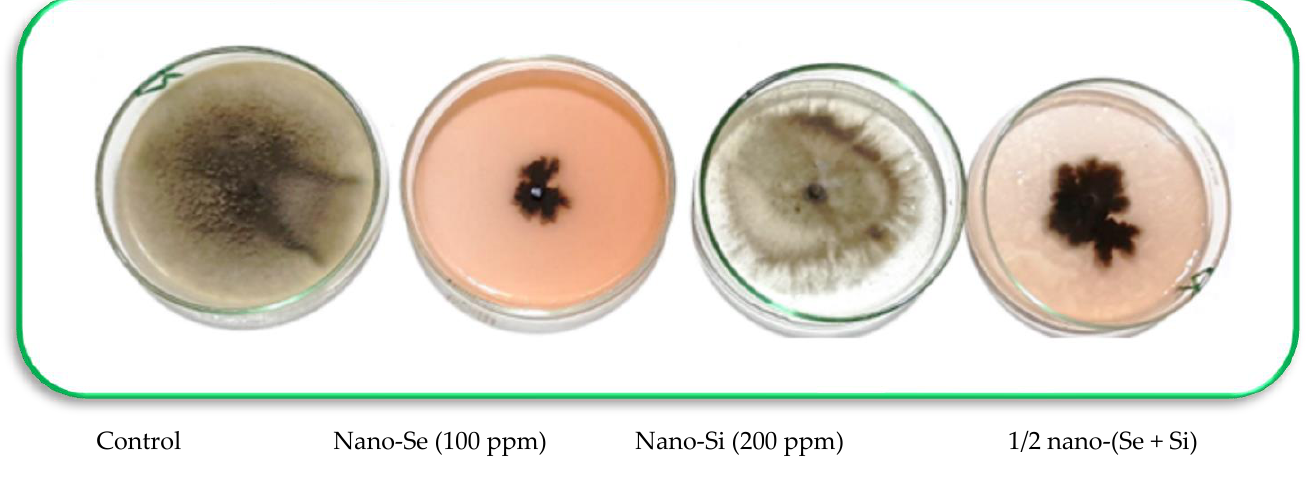
Figure 3. Images illustrating of the inhibition of Alternaria alternata mycelial growth after some of the treatments in the in vitro experiments. Control = no treatment (negative control).